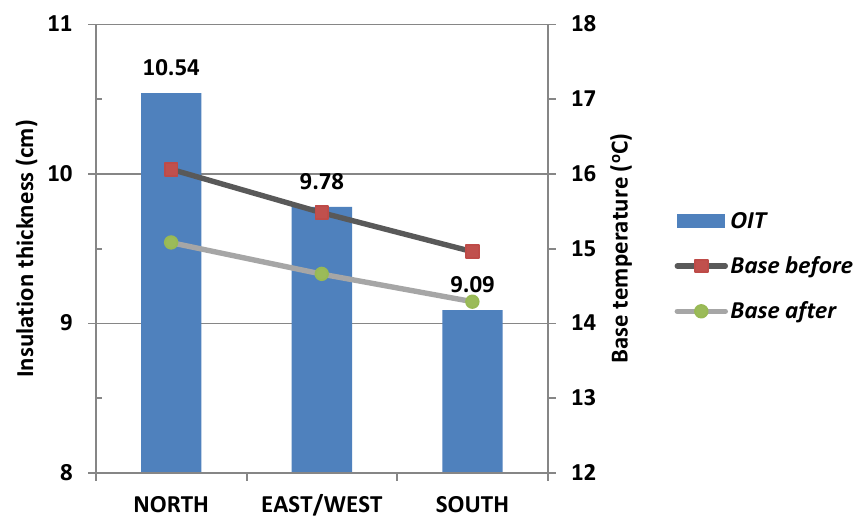
Figure 9. Optimum insulation thicknesses for the various orientations, according to the data of the example, and respective base temperatures before and after the insulation.